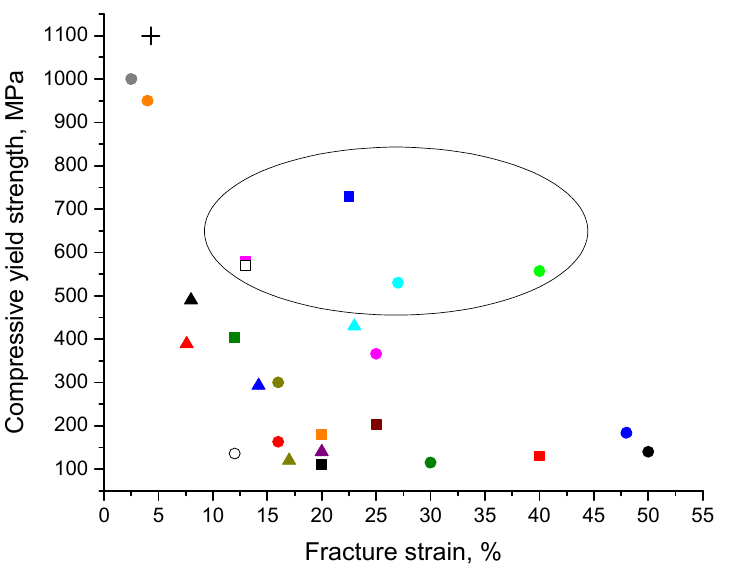
Figure 17. Compressive yield strength–fracture strain data for Al and Al alloy matrix metallic glass (amorphous alloy) ‐ reinforced composites: